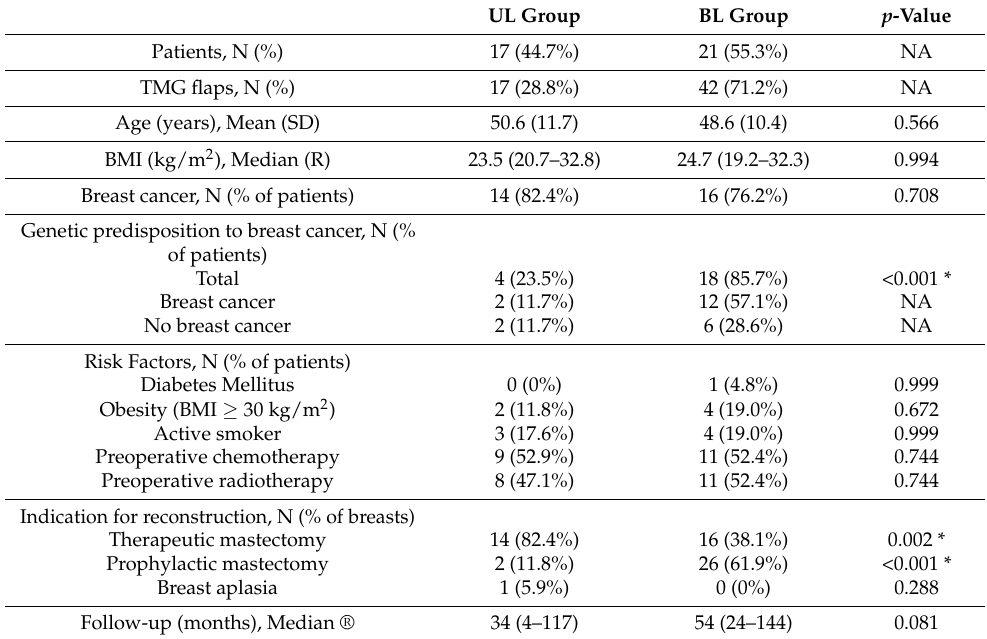
Table 1. Patient